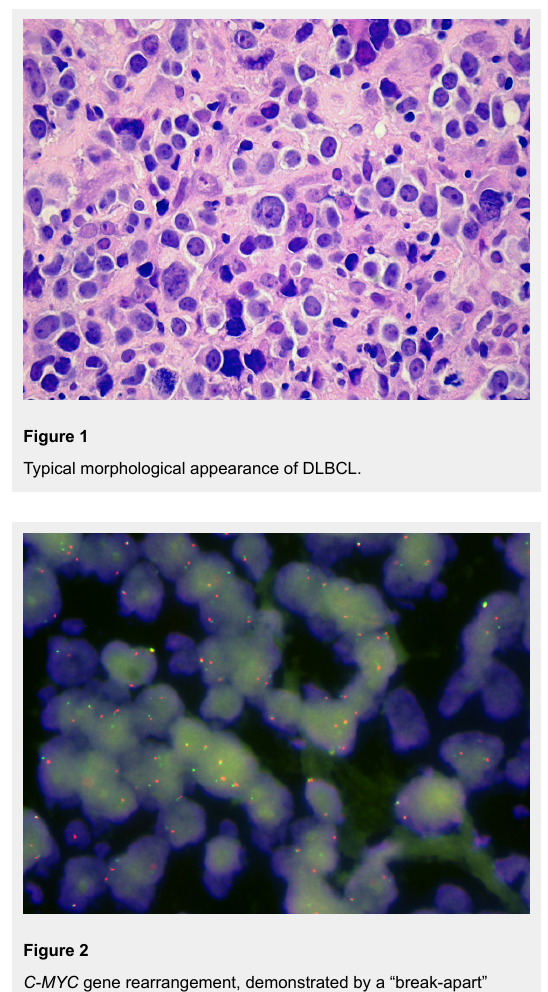
C-MYC gene rearrangement, demonstrated by a “break-apart” FISH probe. Note free green and red signals corresponding to the rearranged allele as well as fused signals corresponding to the second non-rearranged